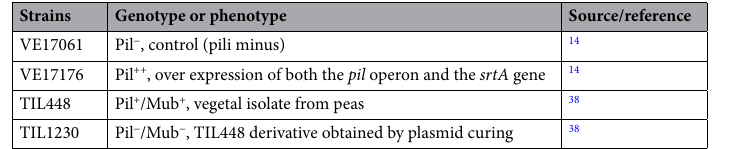
Table 1. L. lactis strains used in this